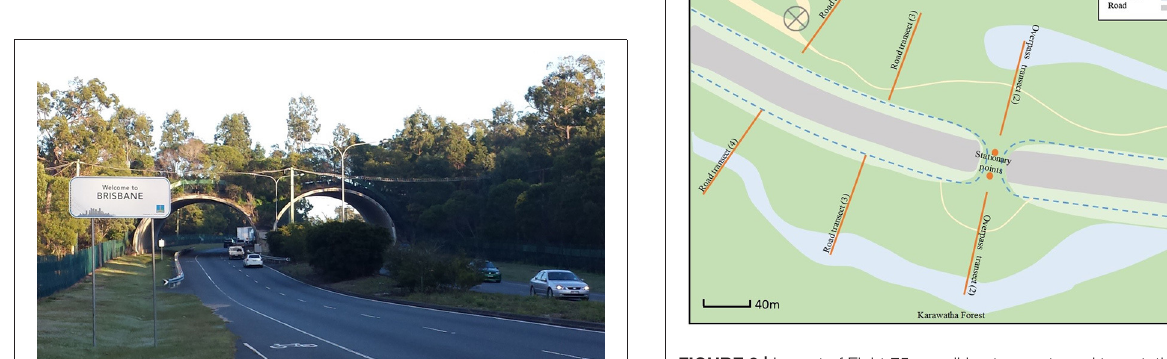
FIGURE 2 | Layout of Eight 75m walking transects and two stationary points, used to record bat call activity throughout Karawatha Forest and Kuraby